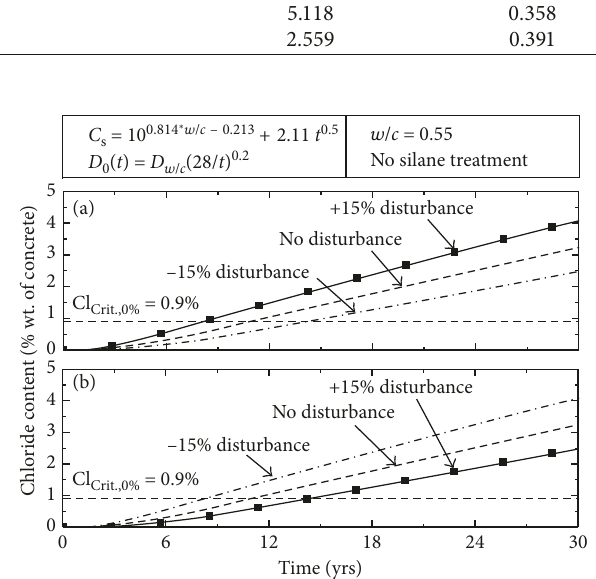
Figure 8: Chloride content for original concrete without and with disturbance on (a) w / c and (b)